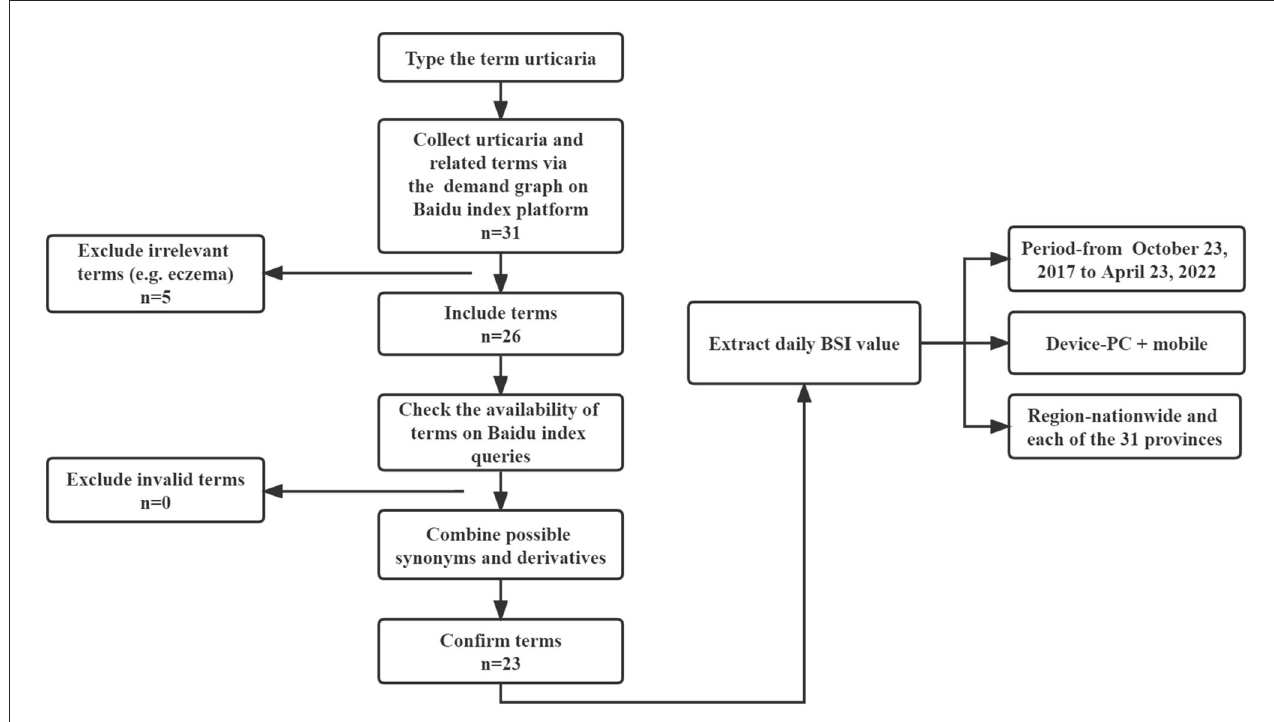
FIGURE1 Flowchart for searching terms identification.